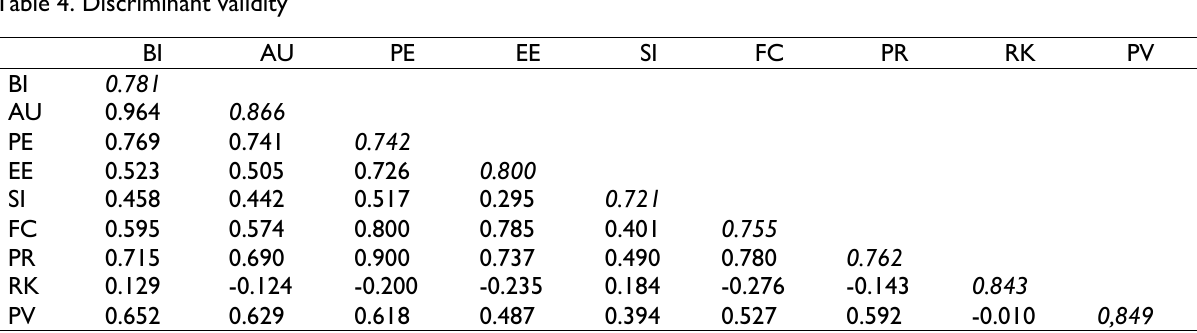
Table 4. Discriminant validity